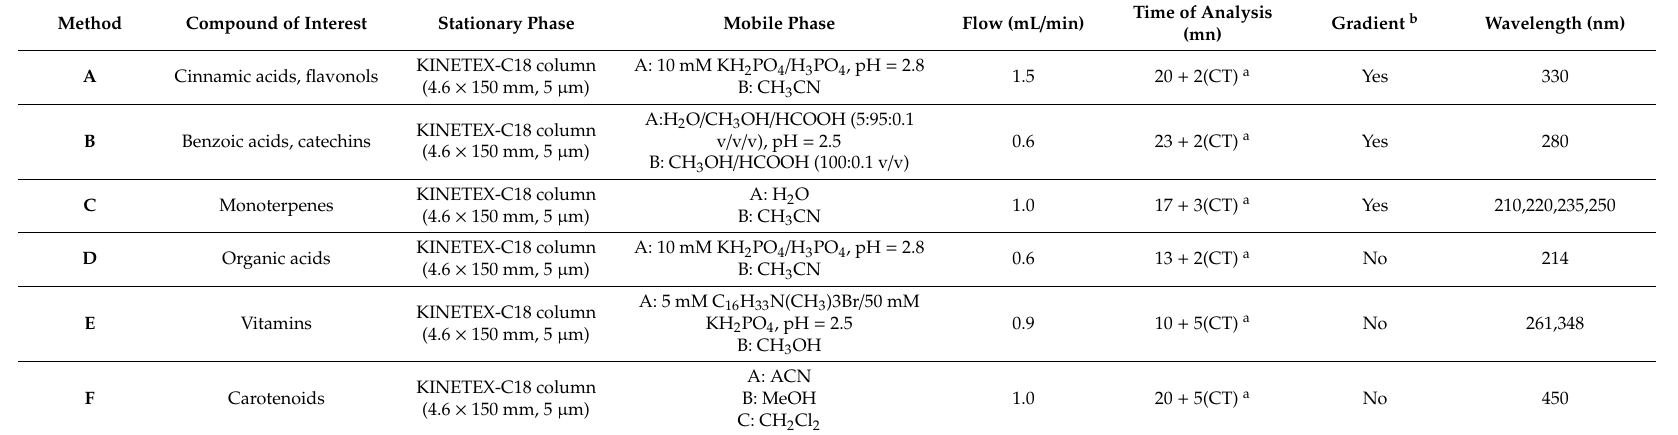
Table 7. Chromatographic conditions of each used